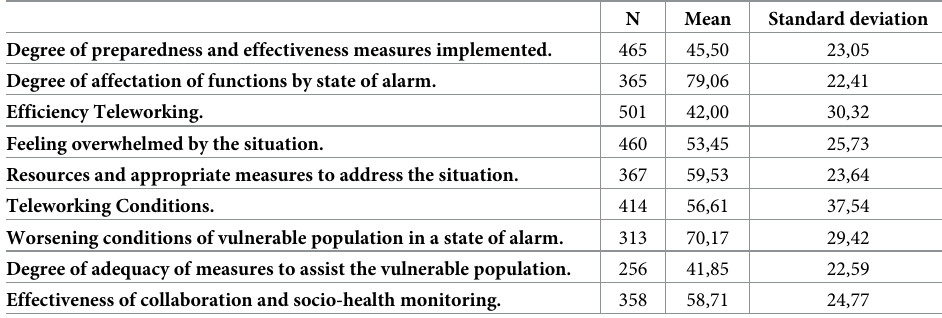
Table 3. Average scores obtained in the dimensions of the